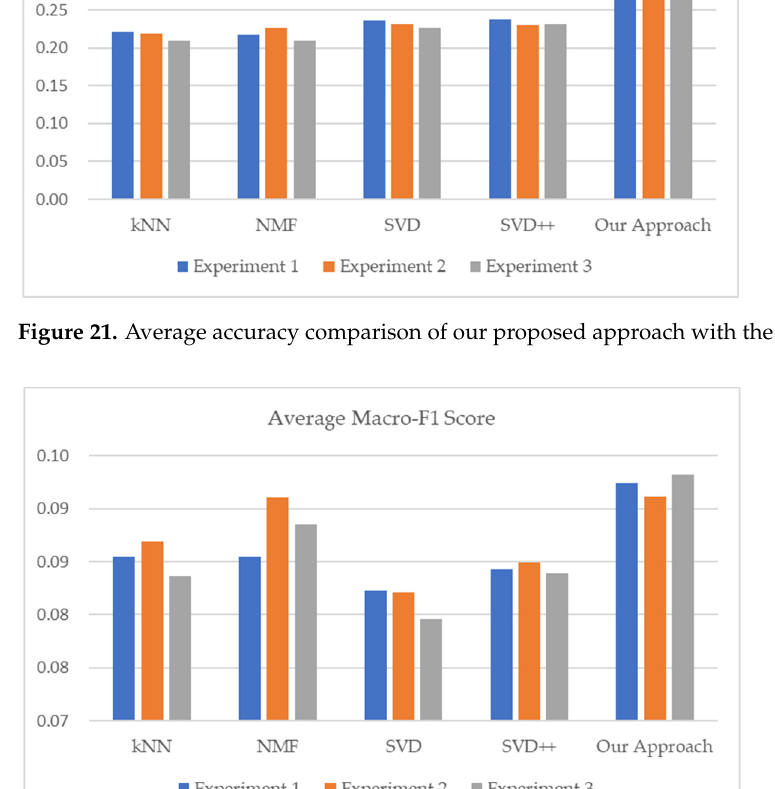
Figure 22. Average macro F1-score comparison of our proposed approach with the other approaches.